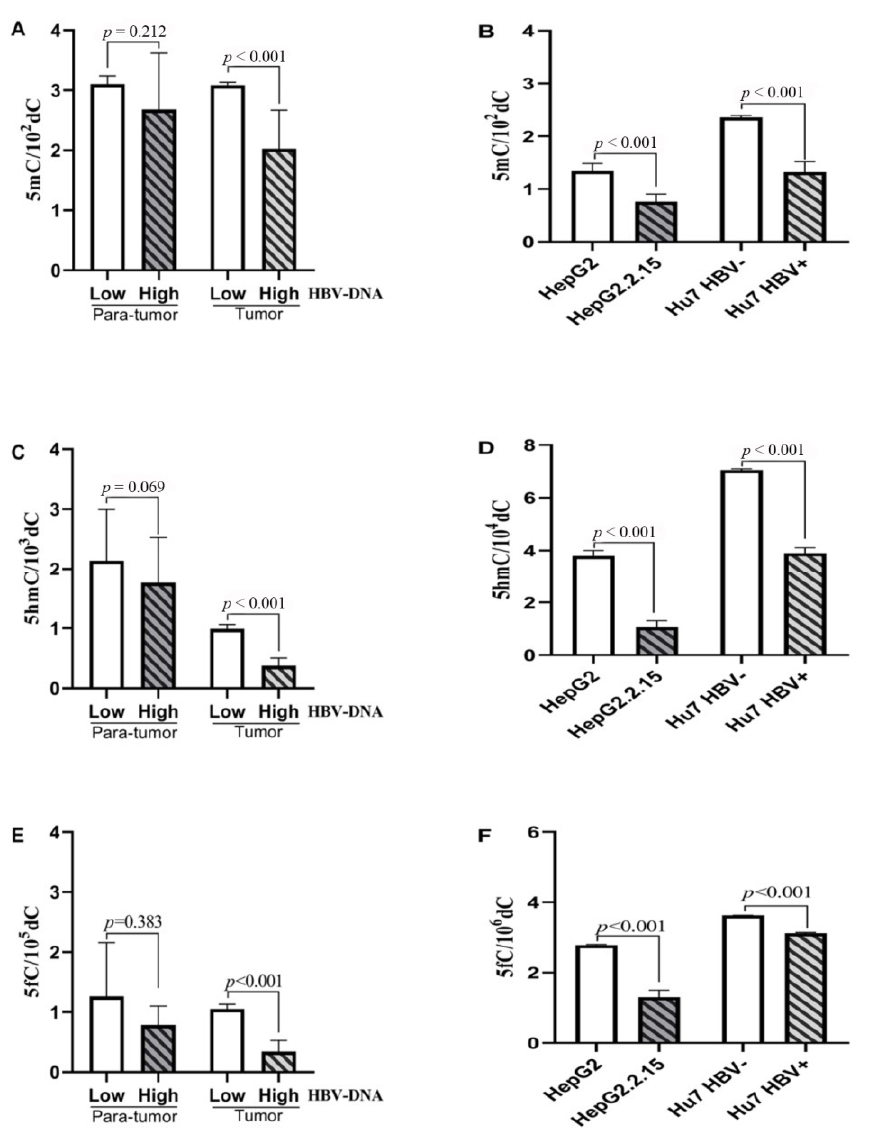
Figure 2. The genomic 5mC, 5fC and 5hmC levels within SHCC Genome Associated with HBV DNA Level. The genomic 5mC, 5fC and 5hmC levels obviously declined in the HBV DNA-high group than the HBV DNA-low group of SHCC tissues ( A , C , E ). The genomic 5mC, 5fC and 5hmC levels obviously decreased in HepG2.2.15 and Hu7 HBV+ cells in comparison with the original cell lines ( B , D , F